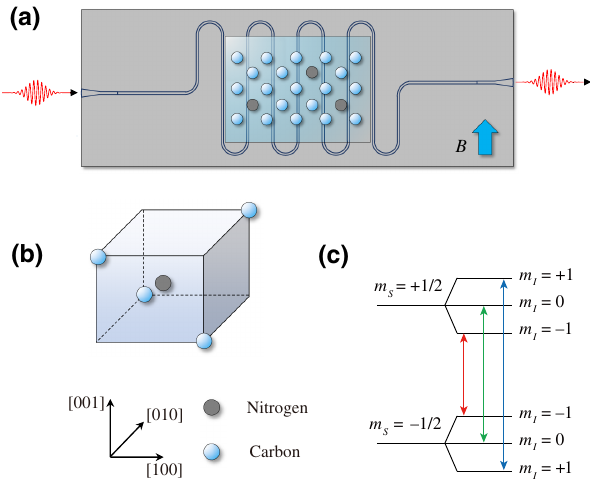
FIG. 1. (a) A schematic of the hybrid system. The diamond sample with P1 centers is glued on a coplanar-waveguide res- onator. (b) A P1 center that involves the substitution of a carbon atom by a nitrogen atom. (c) The energy levels and allowed state transitions in the P1